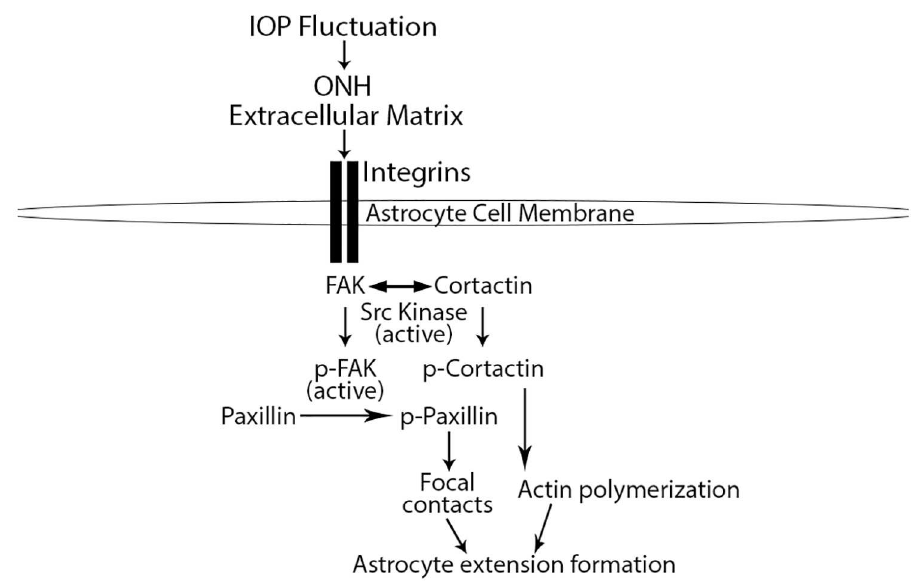
Fig 7. Model of optic nerve head astrocyte signaling downstream of integrin activation in response intraocular pressurefluctuation. Physiologicand experimental intraocularpressure (IOP) fluctuationwithin the optic nerve head (ONH) results in tissue strain and extracellular matrix (ECM) stretch. Interaction between the ECM and integrin receptors on astrocyte cell membranes, leads to integrinactivity, which phosphorylate focal adhesionkinase (p-FAK). Active p-FAK can target paxillinfor phosphorylation, which is important for focal contact/adhesion formation. FAK phosphorylation also allows for cortactin phosphorylation through active FAK and Src kinase. Phosphorylated cortactin enhances actin polymerization. Increasedfocal contact formation and actin polymerization are requiredfor dynamicastrocyte extensionformation and maintenance within the